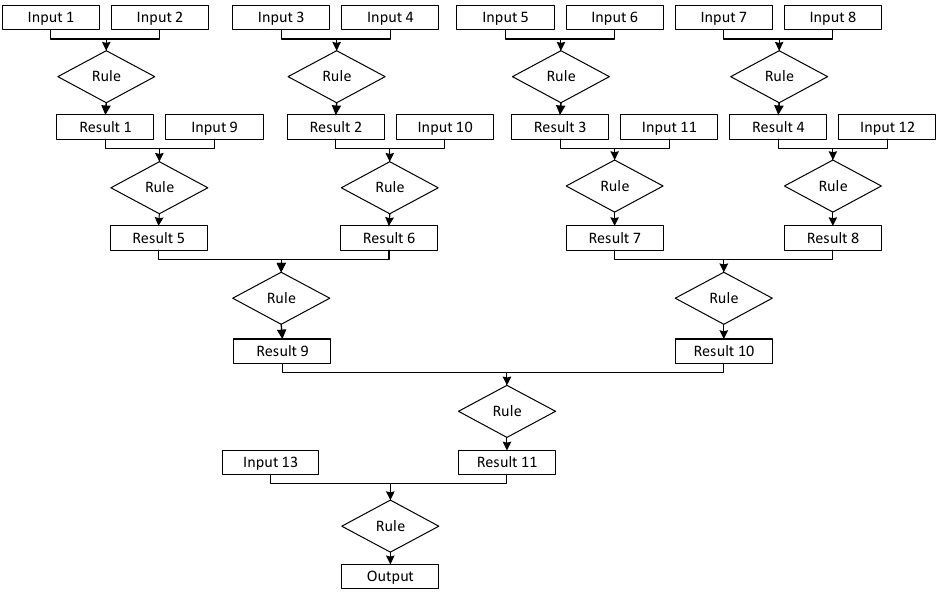
Figure 2. Logical design of Network 2.